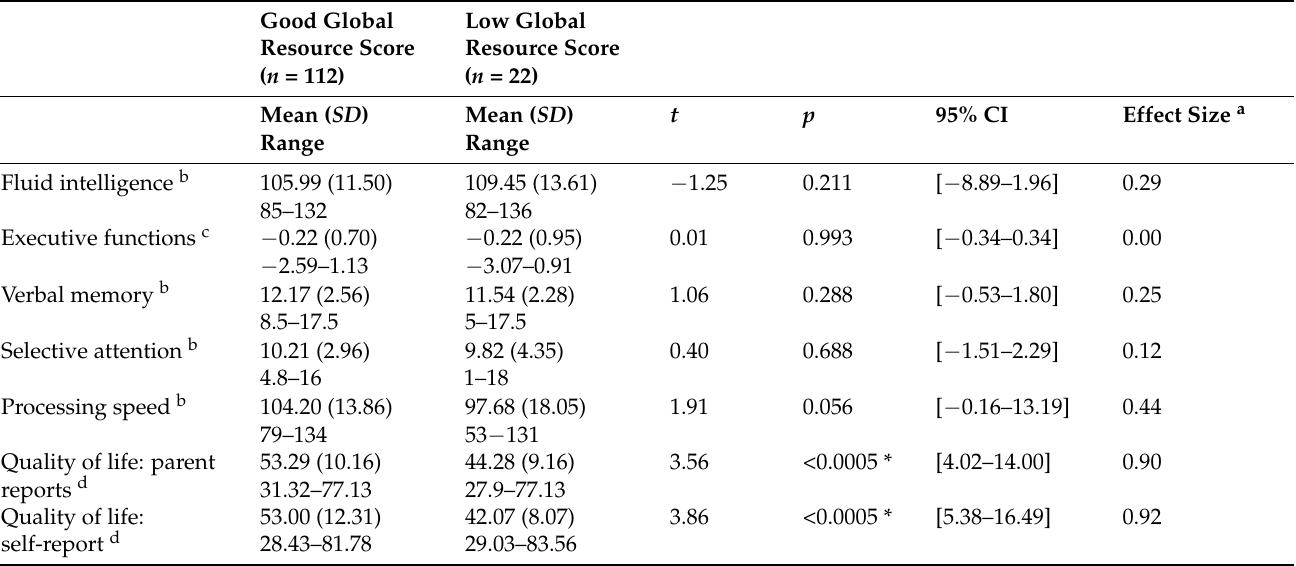
Table 4. Group Means of Cognition and Health-Related Quality of Life in Respect to High vs. Low Global Resource